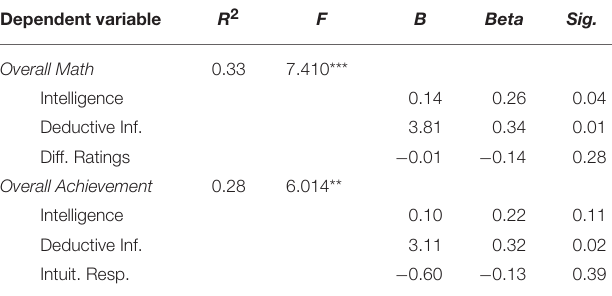
TABLE 4 | Regression analyses of Intelligence, Deductive Inferences and Cognitive Reflection (either Difficulty Ratings or Intuitive Responses) on the two Overall Achievement measures (Overall Math and Overall Achievement without